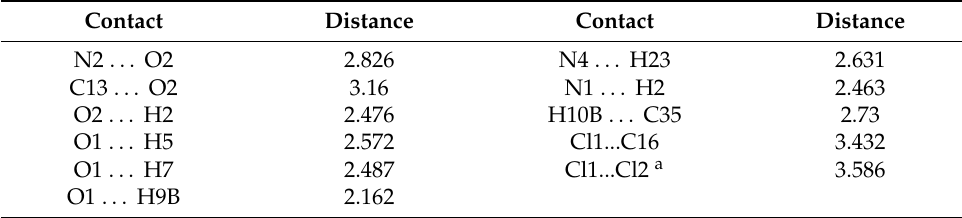
Figure 4. Hirshfeld surfaces of 4 . Table 4. Intermolecular interactions and their distances in 4 a